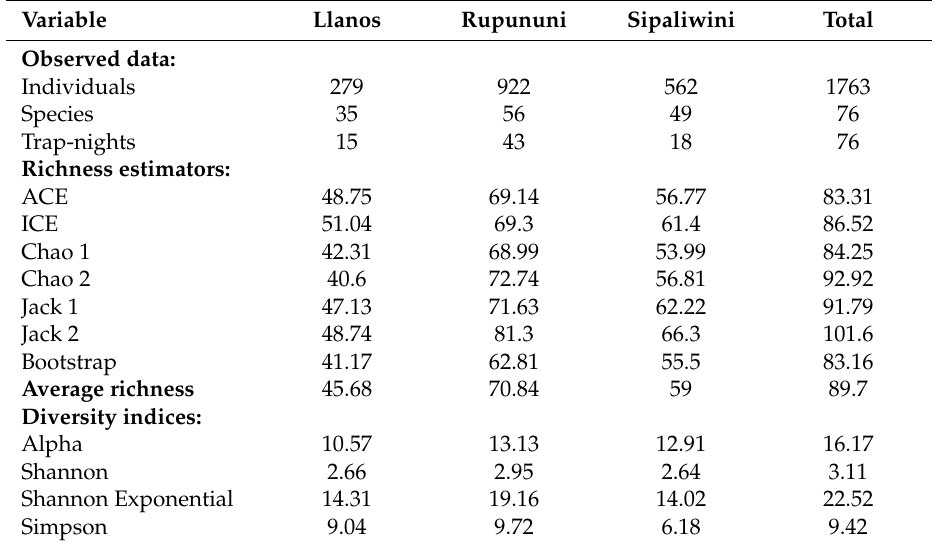
Table 1. Summary of bat survey data and biodiversity measures in the Guianan savannas. (ACE: Abundance-based Coverage Estimators ICE: Incidence-based Coverage